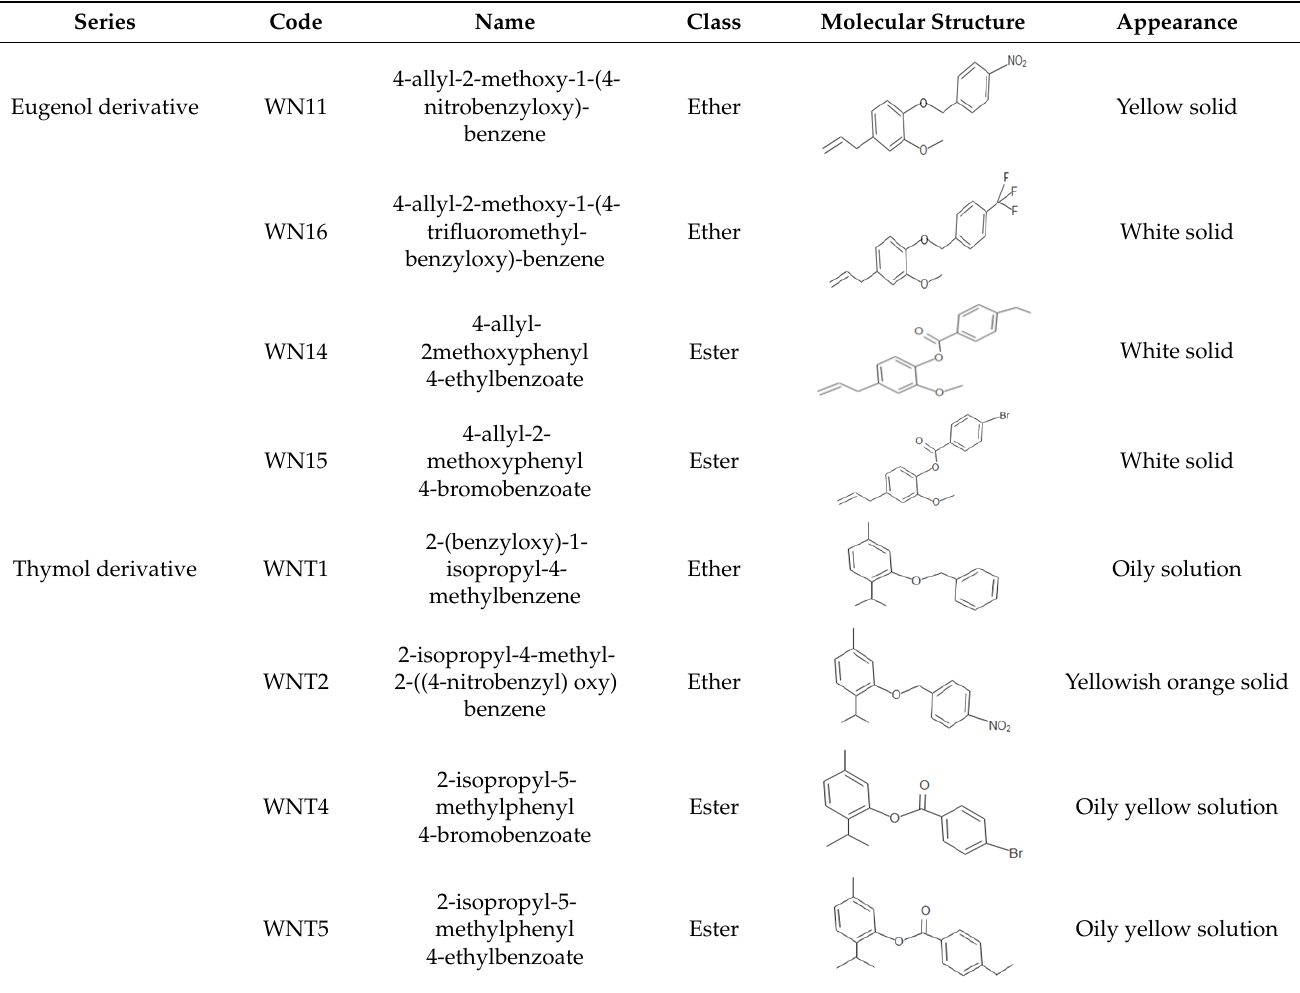
Table 1. Information regarding eugenol and thymol derivatives.